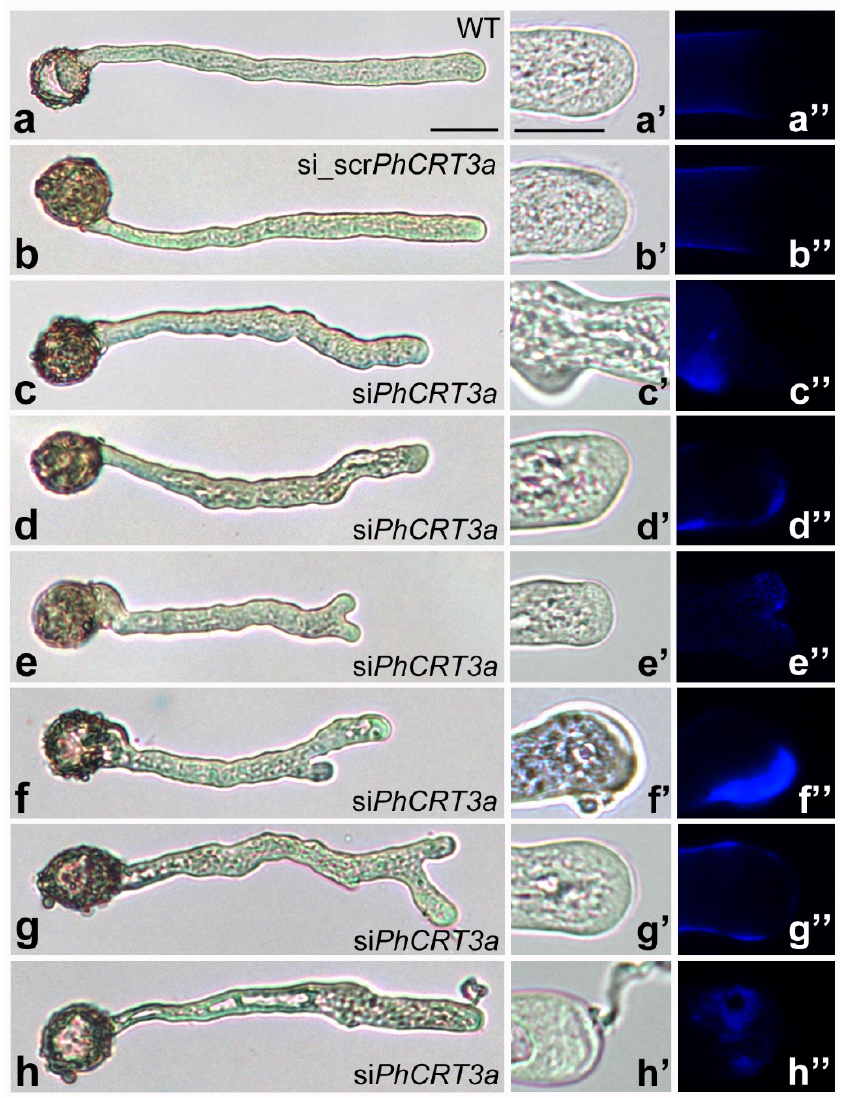
Figure 5. Morphology and callose deposition of/in Petunia wild-type (WT), scr_si PhCRT3a , and si PhCRT3a elongated pollen tubes. Both WT ( a – a’ ) and scr_si PhCRT3a ( b – b’ ) pollen tubes have a typical cylindrical shape with a clear zone in the growing tip; callose is uniformly distributed along the entire tube shank except at the elongating tip ( a” , b” ), respectively. In contrast, si PhCRT3a pollen tubes exhibit disturbed morphology ( c – h ) compared to control tubes, including misshapen tips ( c , d , d’ ), twists in the shank ( c – h ), highly vacuolated cytoplasm ( d – f ) — even in the subapical domain ( d’ , f’ ) — and bifurcated tips ( e – g ) with one of them being dominant during elongation ( f , g ). Most of the si PhCRT3a pollen tubes exhibit increased callose deposition in the apical domain ( d” , f” , h” ) and in the twisted shank ( c” ). Finally, the growth of si PhCRT3a pollen tubes was inhibited, and some of them ruptured ( h , h’ ). Bar: 50 µm ( a – h ); 20 µm ( a’ , a” – h’ , h” ).